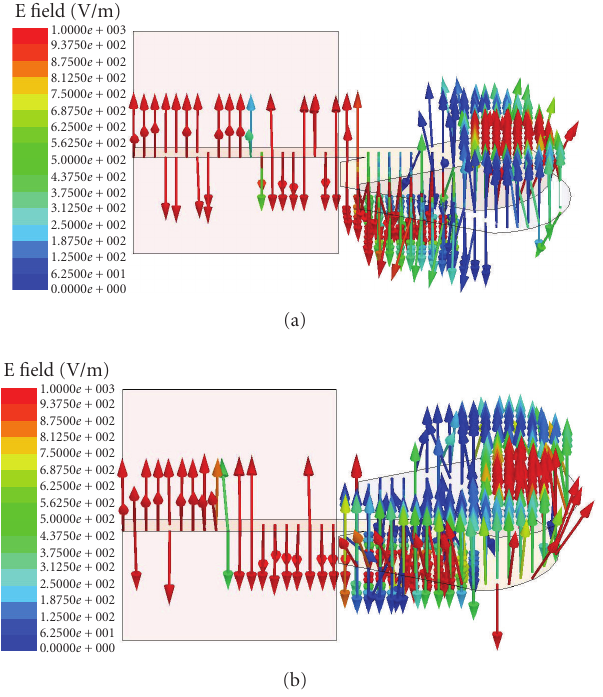
Figure 4: Electric field distribution in the antenna at center fre- quency: (a) patch F 2 in the same direction as patch F 1 , (b) patch F 2 in the opposite direction to F 1 [ L = 67, W G = 67, L G = 29, L M = 15, W . 5, L R S . 3, S . 5, S W M = 3, R = 7 R = 19, R = 11, H 1 = 0 L 1 = 6 H 2 = 3, . 25, h = 1 . 6 (units in mm), ε . 4]. S L 2 = 5 r = 4